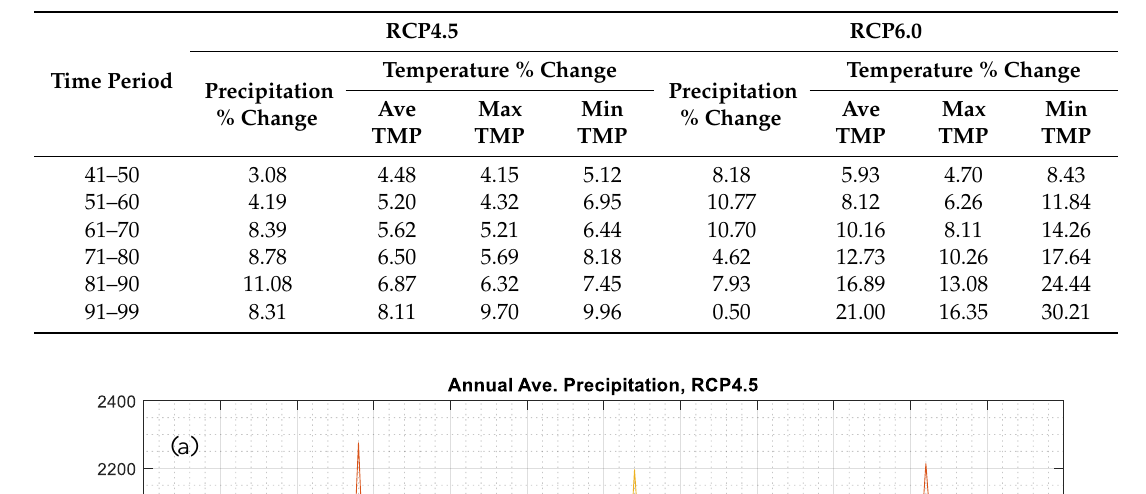
Table 7. Percent changes of precipitation and temperature under di ff erent scenarios.